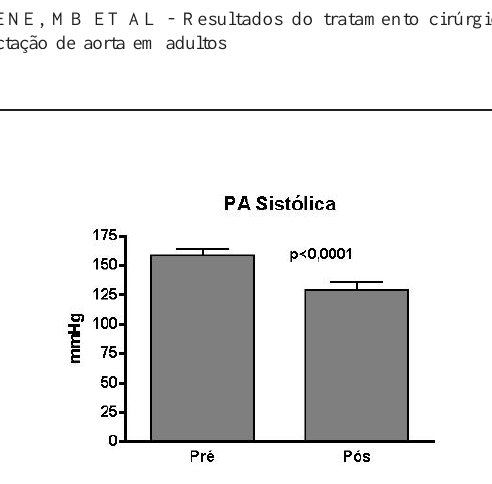
Fig. 5 - Comportamento da pressão arterial sistólica nos períodos pré e pós-operatórios. PA = pressão arterial; mmHg = milímetros de mercúrio